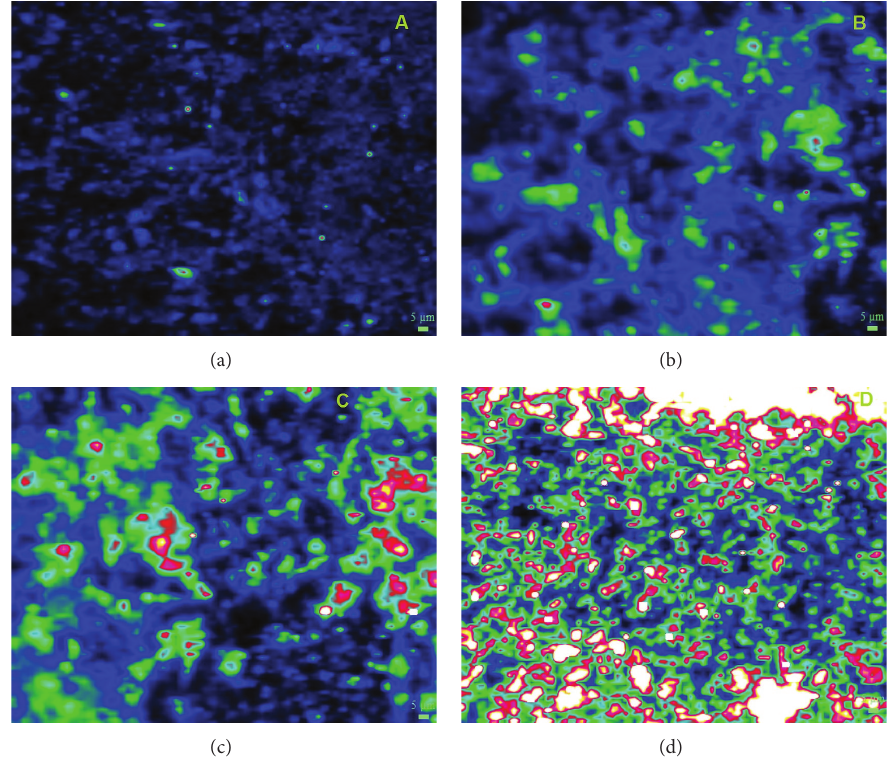
Figure 1: Raman images of M74 TlBa 2 Ca 2 Cu 3 O 9 high- 𝑇 𝐶 superconductor films with Tl-1223 phase. (a) Raman image at 293 K. (b) Raman image at 153K. (c) Raman image at 133 K. (d) Raman image at 77